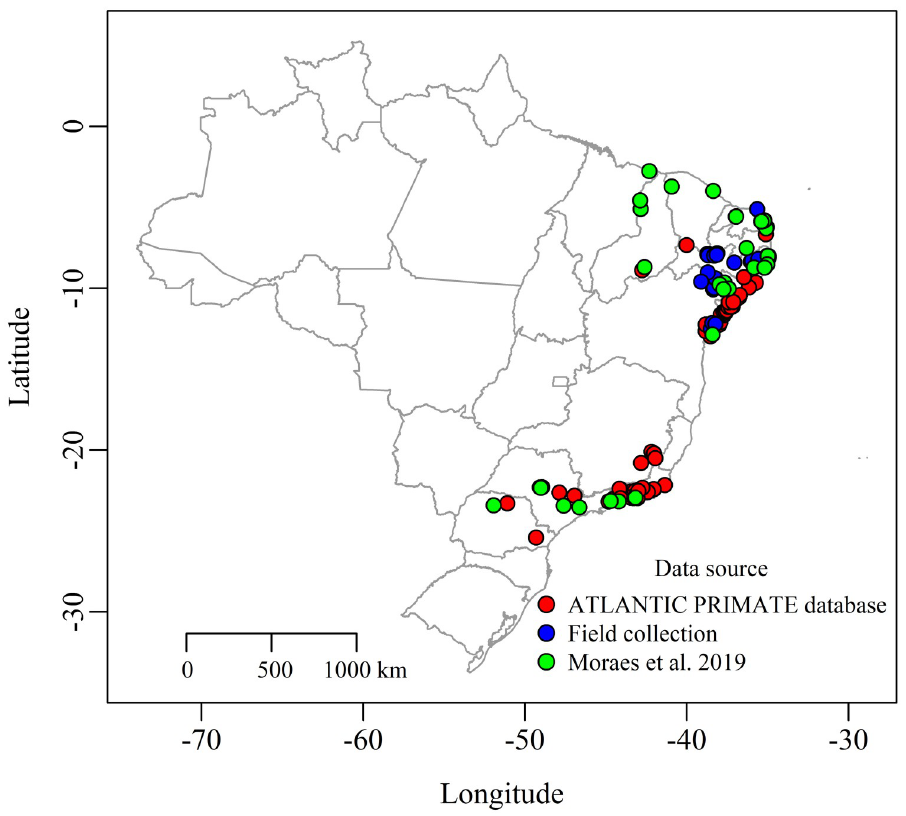
Fig 4. Presence only occurrence locations of Callithrix jacchus in Brazil. Red dots show locations published in the ATLANTIC PRIMATES database, blue dots show locations identified during the field missions performed within this study, and green dots show locations extracted from Moraes et al . 2019 [23]. Country, region and district maps were obtained from the GADM (http://www.gadm.org//) database, freely-available for academic use, using the getData function from the raster package of R (map layer can be found here: https://biogeo.ucdavis.edu/data/gadm3.6/Rsp/ gadm36_BRA_2_sp.rds)).